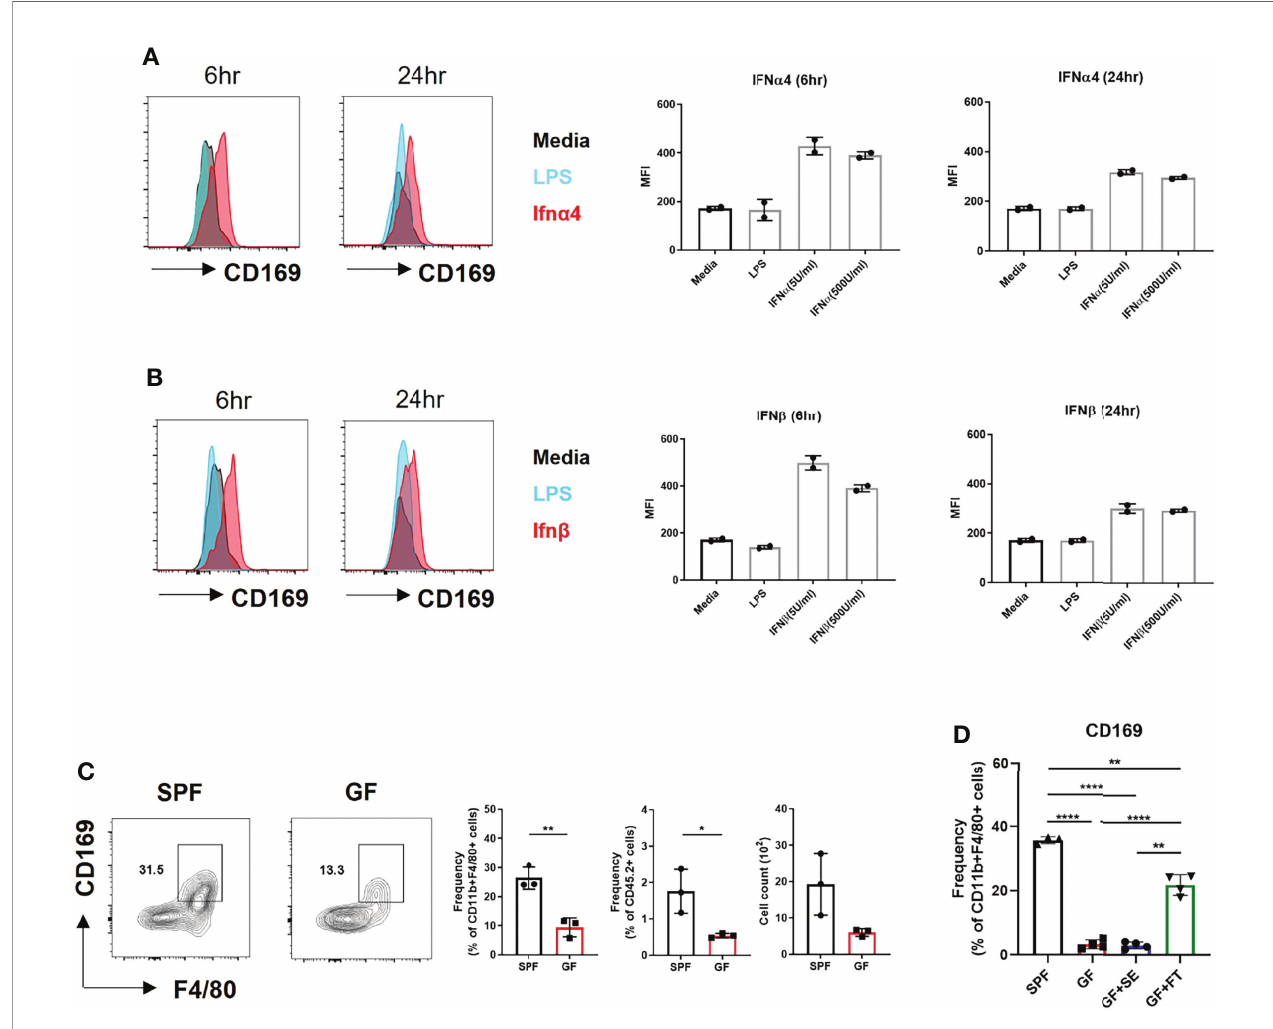
FIGURE 3 | Microbiota-induced type I Interferon signaling dictates CD169 + expression in BMDMs and skin macrophages. (A) Representative FACS plot and bar graphs showing mean fl uorescence intensity (MFI) of CD169 in BMDMs challenged with various doses of recombinant IFN a 4 (5 U/mL and 500 U/mL) and (B) recombinant IFN b (5 U/mL and 500 U/mL) at different time points (6 hours and 24 hours). Data represent two independent experiments. (C) Representative FACS plot showing frequency and cell counts of F4/80 + CD169 + cells in skin of SPF and GF mice (n = 3 per group). Gated on FSC/SSC, PI - , singlet, CD45.2 + , CD11b + cells. Data are expressed as means ± SEM (*p<0.05, **p<0.01). Data represent three independent experiments. (D) Frequency of CD169 + macrophages in skin of SPF mice (n = 3) with DPBS oral gavage (SPF), GF mice (n = 3) with DPBS oral gavage (GF), GF mice (n = 3) with S. epidermis topical application (GF+SE) and GF mice (n = 3) with fecal transplantation (GF+FT). The cells were gated on FSC/SSC, PI - , singlet, CD45.2 + , CD11b + , F4/80 + cells. Combined data of three independent experiments are shown. Data are expressed as means ± SEM (**p < 0.01, ***p < 0.001, ****p <